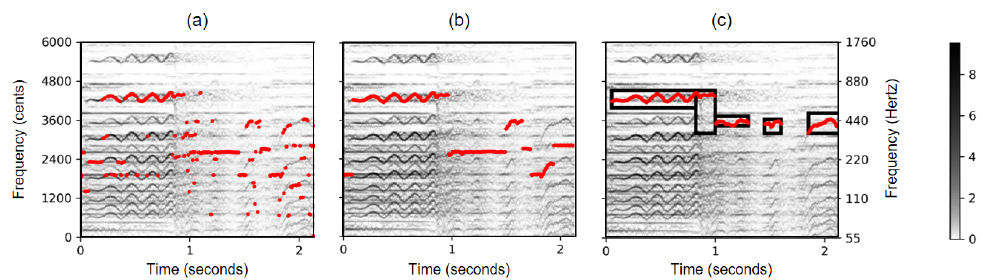
Figure 23. Salience representation with trajectories computed by ( a ) a frame-wise approach, ( b ) an approach using continuity constraints, and ( c ) a score-informed